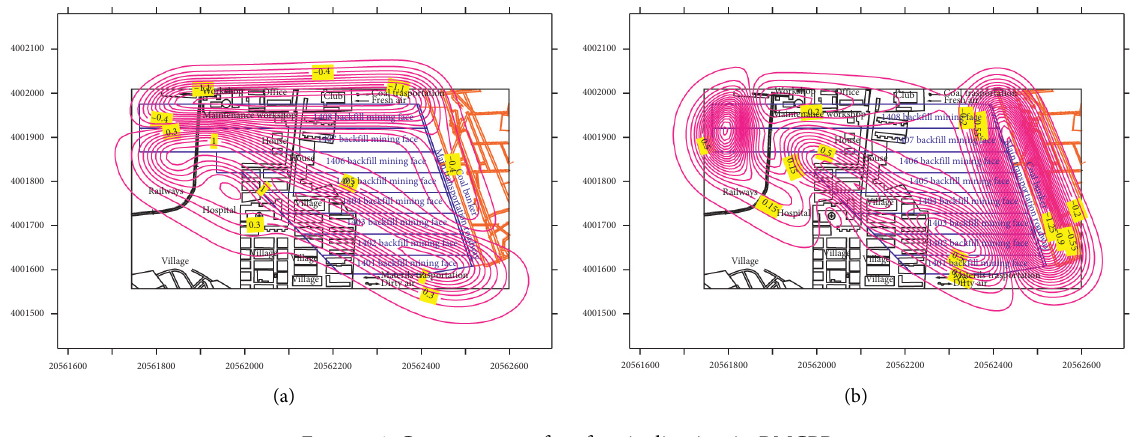
Figure 6: Contour map of surface inclination in the north-south and east-west lines in strip mining were surface movement and deformation extremum is given in derived and are shown in Figures 10 ∼ 14. The Table 2. surface movement and deformation extrema are listed in Similarly, the horizontal surface deformation, inclina- Table 3. tion, curvature, horizontal movement, and subsidence, along